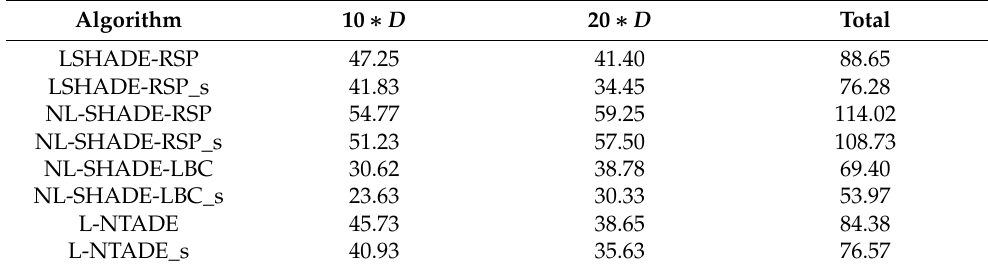
Table 4. Algorithms with and without crossover rate sorting, CEC 2022, Friedman